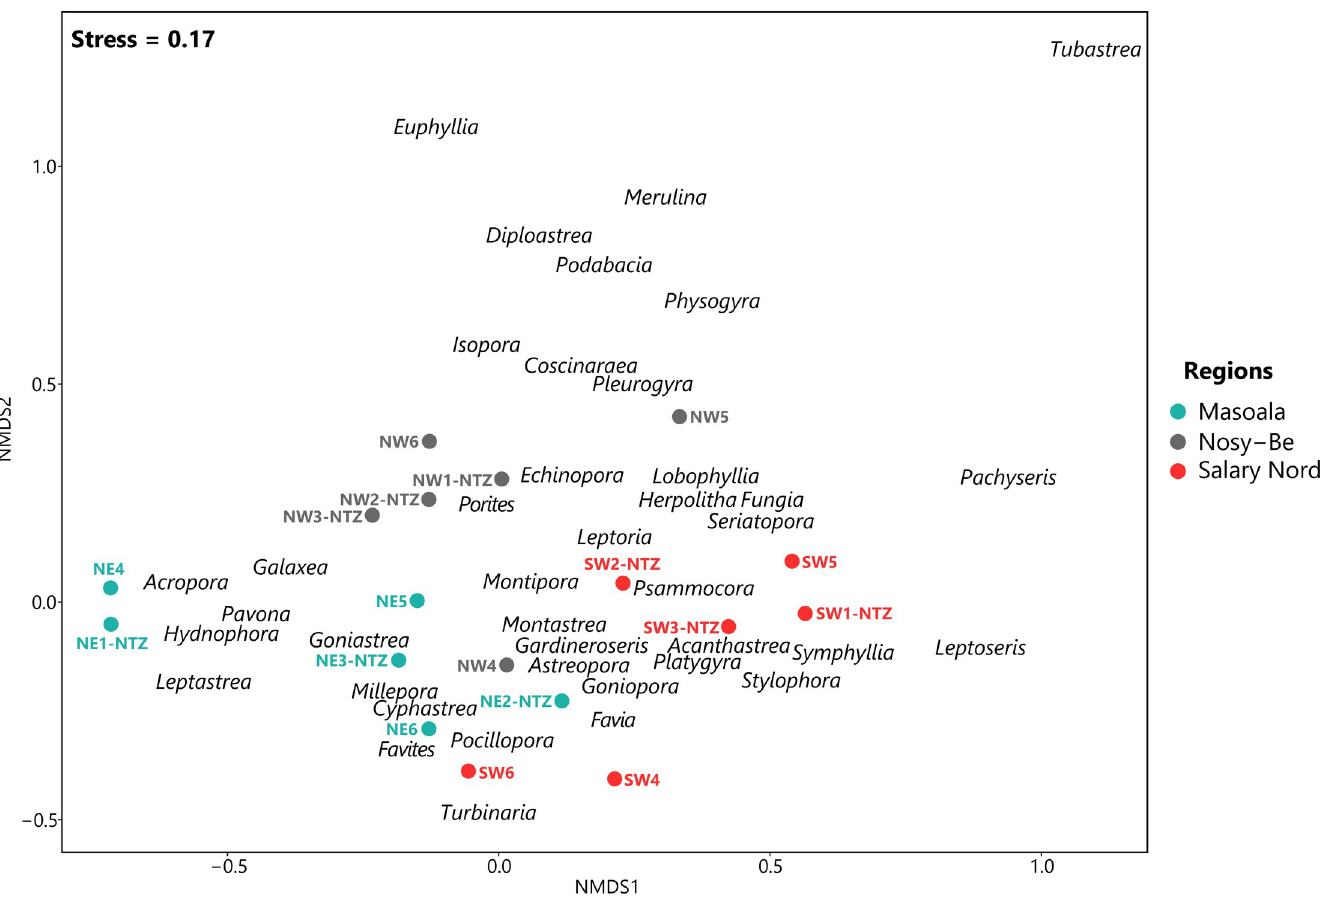
Fig 2. Non-metric multidimensional scaling (nMDS) showing the spatial variation in the composition and abundance of coral assemblages. Analyses are based on the Bray-Curtis dissimilarity index among the 18 stations located in the three regions. Position of stations and coral genera is given along the first two axes.